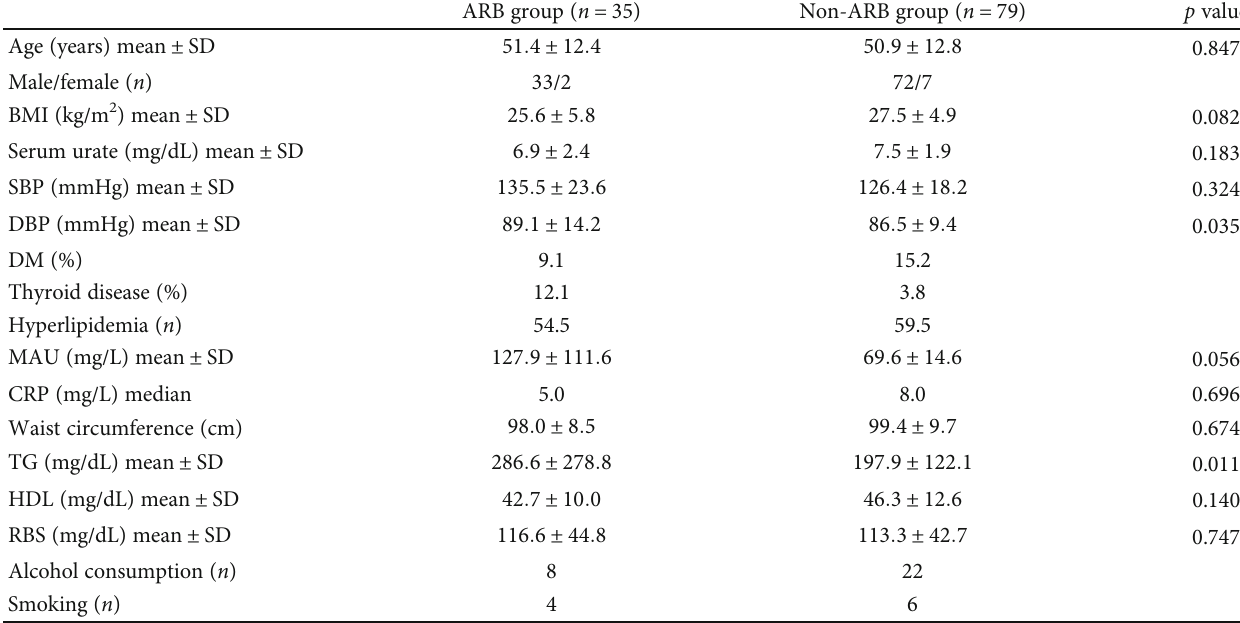
Table 1: Baseline characteristics of the subjects ( n = 114